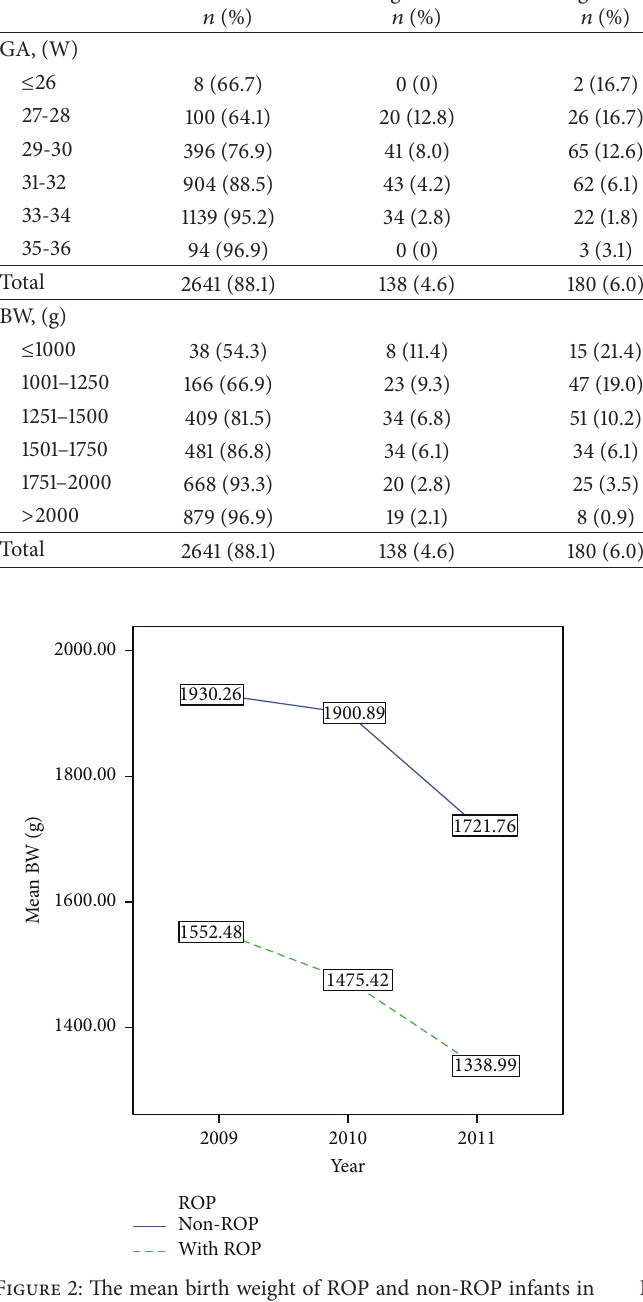
Figure 3: The mean gestational age of ROP and non-ROP infants in 2009, 2010, and